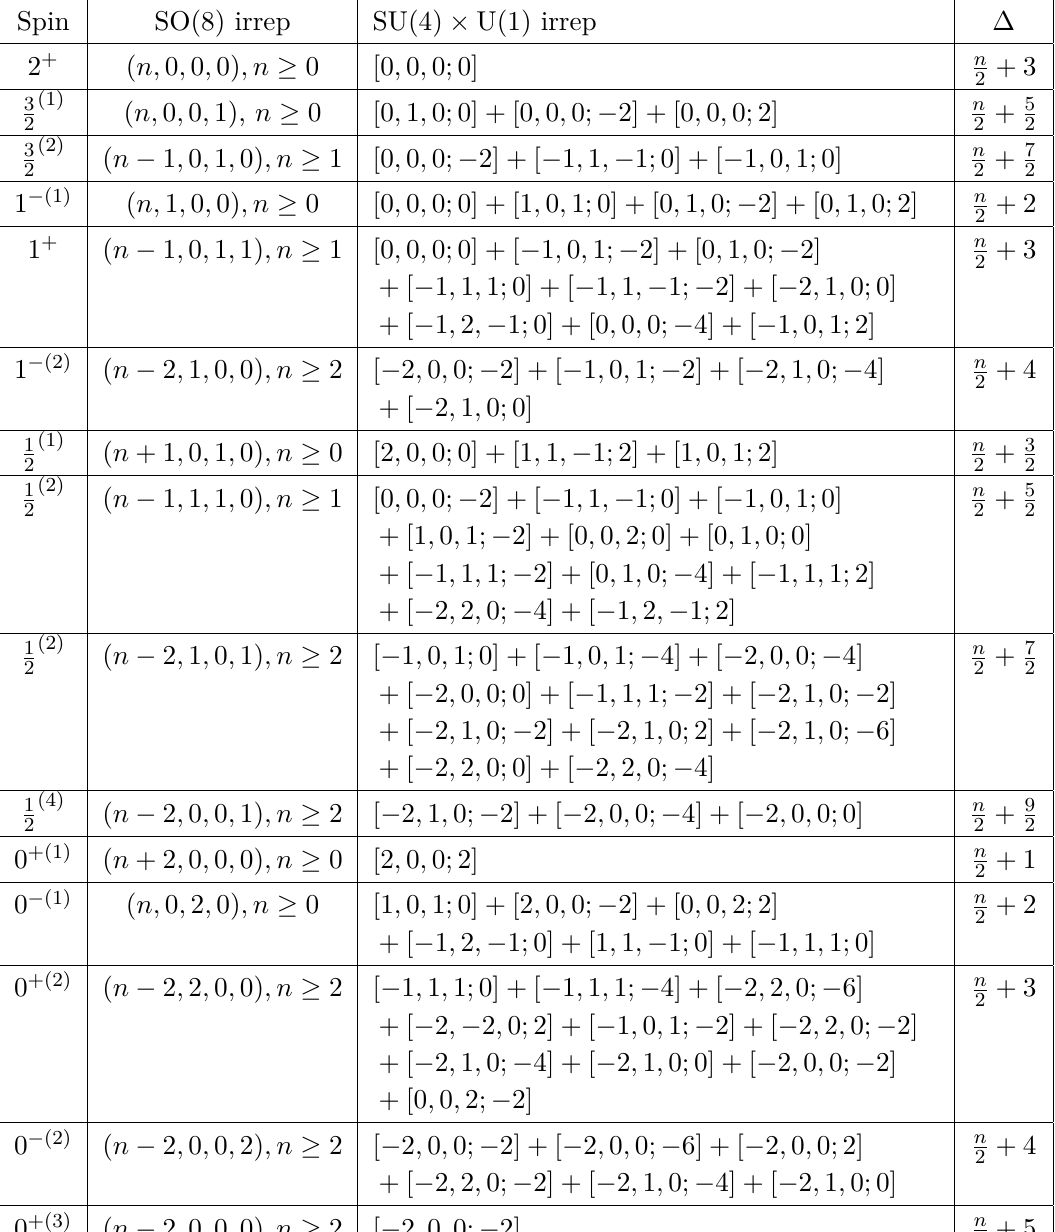
Table 8 . Branching rules for SO(8) → SU(4) × U(1) for the representations of interest in this